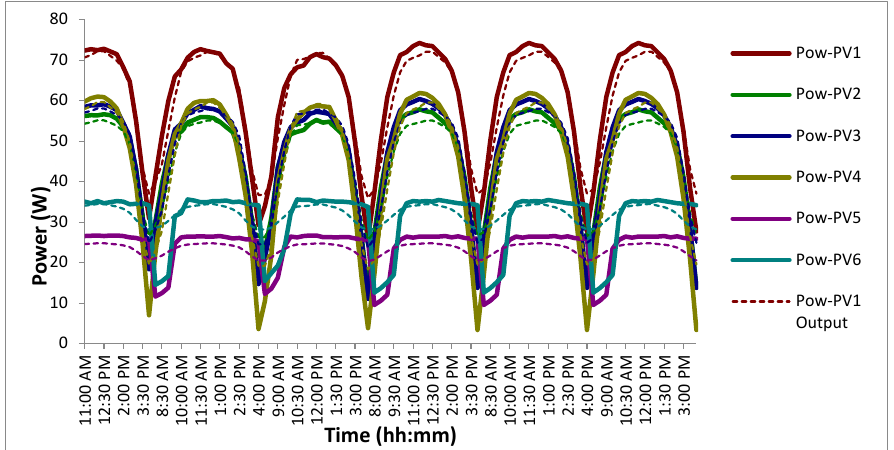
Figure 9. The comparison of prediction of power production for the six PV panels with the actual power production.